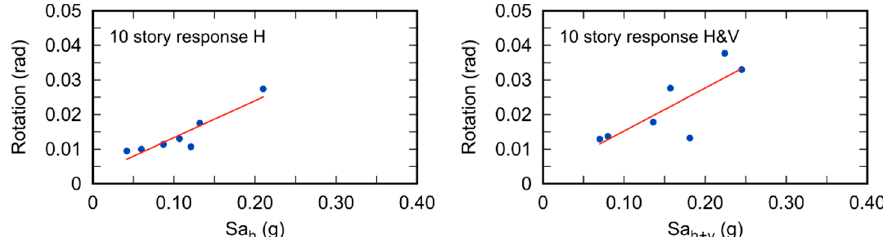
Figure 14. Rotation as a function of Sa for the 10-story building; for beams studied in Figures 10 and 11. Left for the horizontal component, right for the horizontal plus vertical component. Table 7. Accelerations due to horizontal earthquake in the 10-story building.